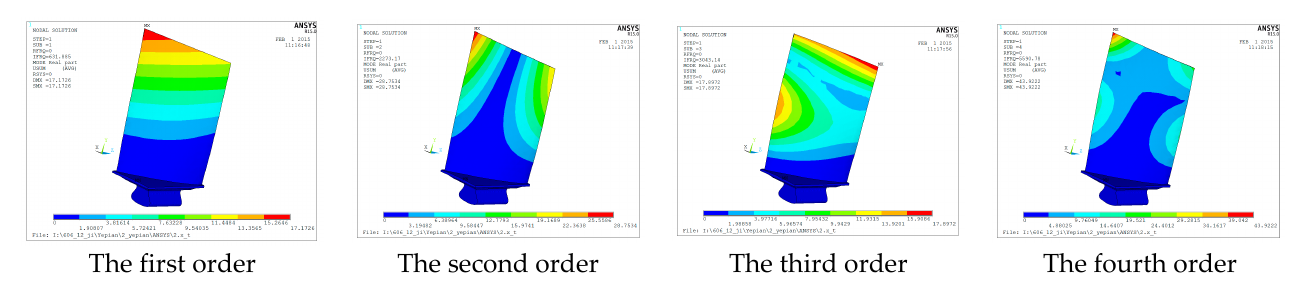
Figure 6. The first four modes of the first stage blade.